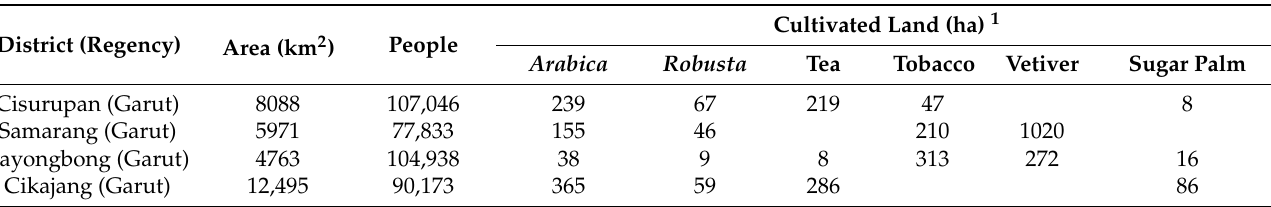
Table 1. Area under cultivation with cashcrops (in hectares, 2016) in the study district, Cisurupan, and three neighboring districts [36].